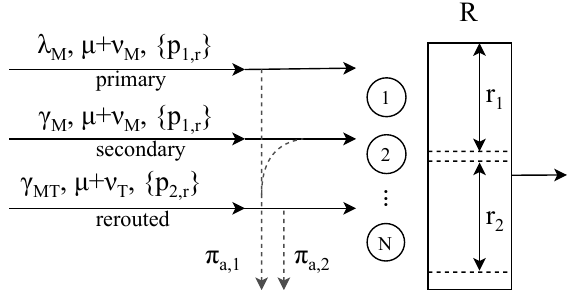
Figure 3. Equivalent ReLS model for mmWave part of